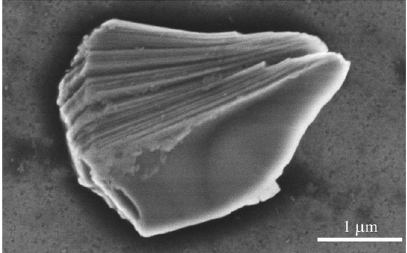
Fig. 4 Typical morphology of a swollen Bi 2 TeI crystal. SEM image of a swollen Bi 2 TeI crystal after the heat treatment with PVP in IPA, revealing expansion of the crystal and twisting of layer